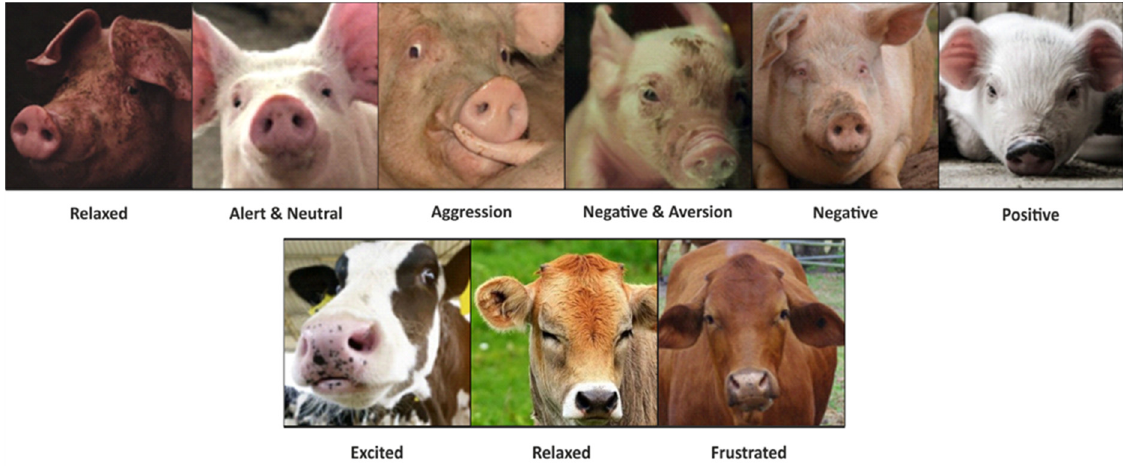
Figure 2. Sample of images from the data set. Facial features of pigs and cows expressing varying emotions.